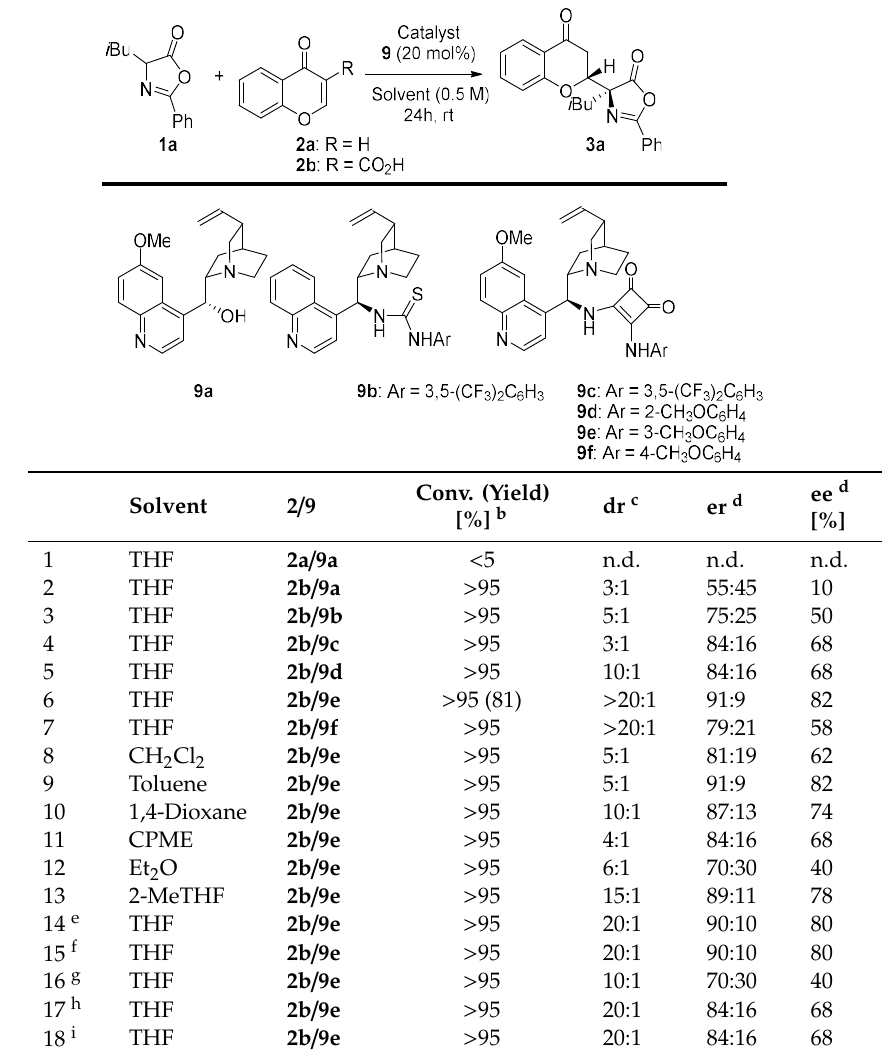
Table 1. Decarboxylative enantioselective synthesis of chromanone 3 bearing an azlactone unit— optimization studies a .